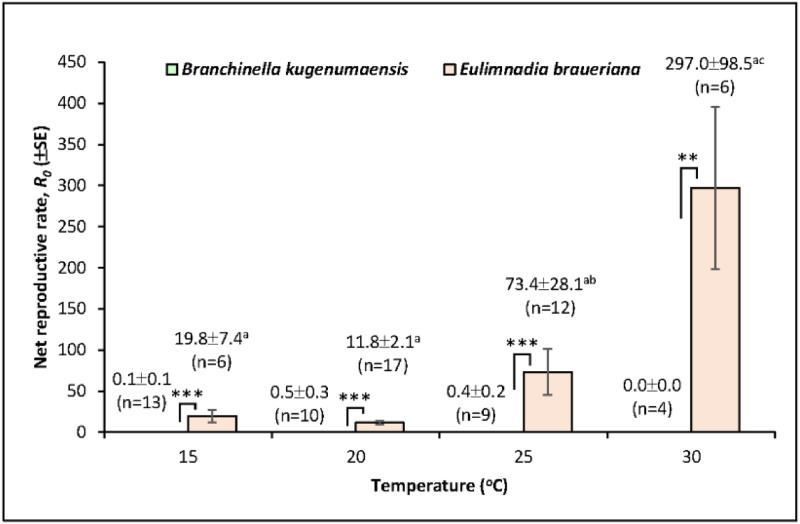
Net reproductive rates (R0) at different temperatures.The symbol star (*) indicated significant difference of R0 between B. kugenumaensis and E. braueriana (**p < 0.010, ***p < 0.001). Different superscript letters (a, b, c) indicated the significant pairwise groups by post hoc analysis.